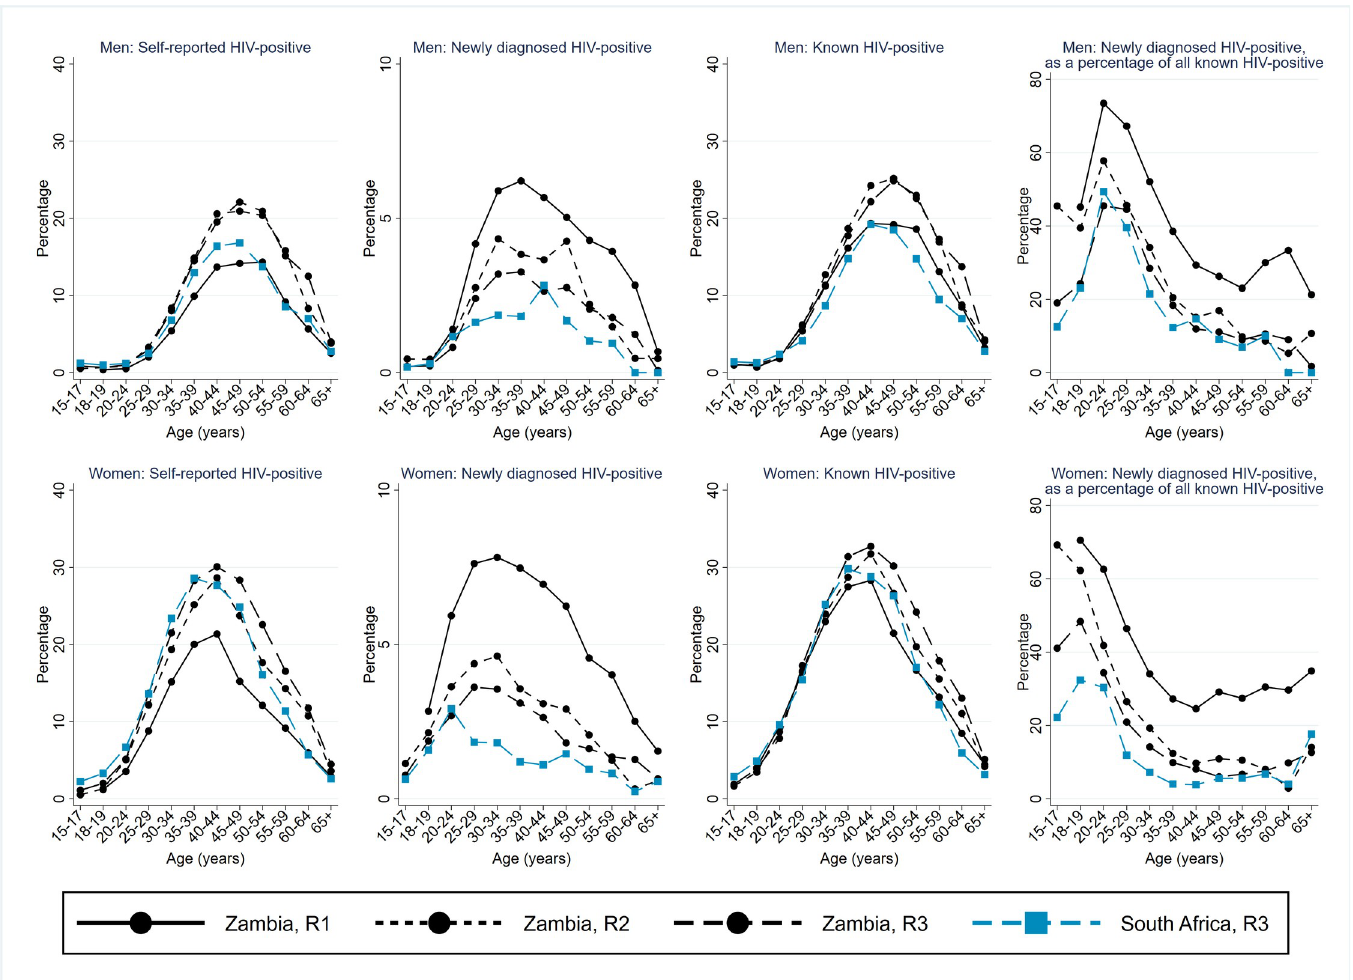
Fig 4. Arm A: Self-report of HIV-positive status, new HIV-positive diagnosis, and total known to be HIV positive, as a percentage of individuals who participated in the intervention; and the percentage of known HIV-positive individuals who were newly diagnosed HIV positive. Zambian communities R1–R3 and SA communities R3, by sex and age group. R1, Round 1; R2, Round 2; R3, Round 3; SA, South